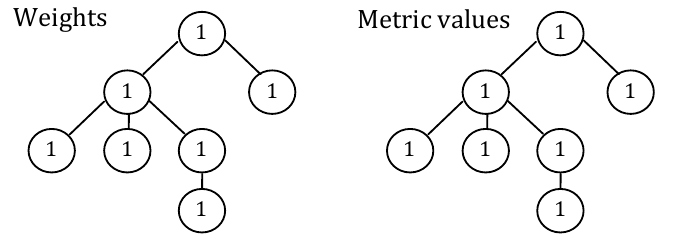
Fig 5. Calculation of the “number of words” as a node-based sentence metric. In this example the result is